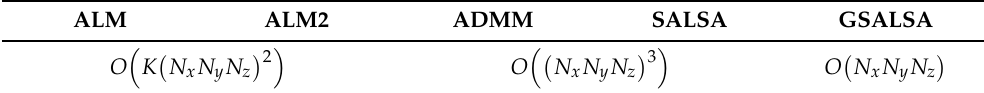
Table 10. Computational complexity of different